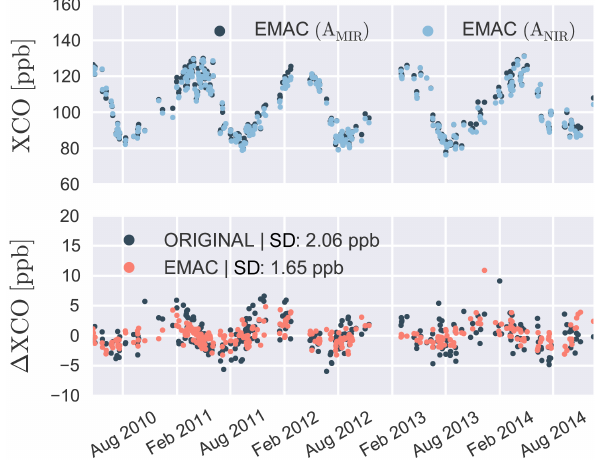
Figure 13. Smoothed XCO time series using NDACC and TCCON averaging kernels and simulated EMAC VMR profiles as the true atmospheric profile (upper panel); the lower panel shows the differ- ence time series of both smoothed time series and is an estimate of the smoothing effect observed in the original time series, which rep- resents the difference of the unmodified standard retrievals as used for NDACC and TCCON (labelled as “ORIGINAL”). For a better comparison of the seasonality, we removed the induced bias in both time